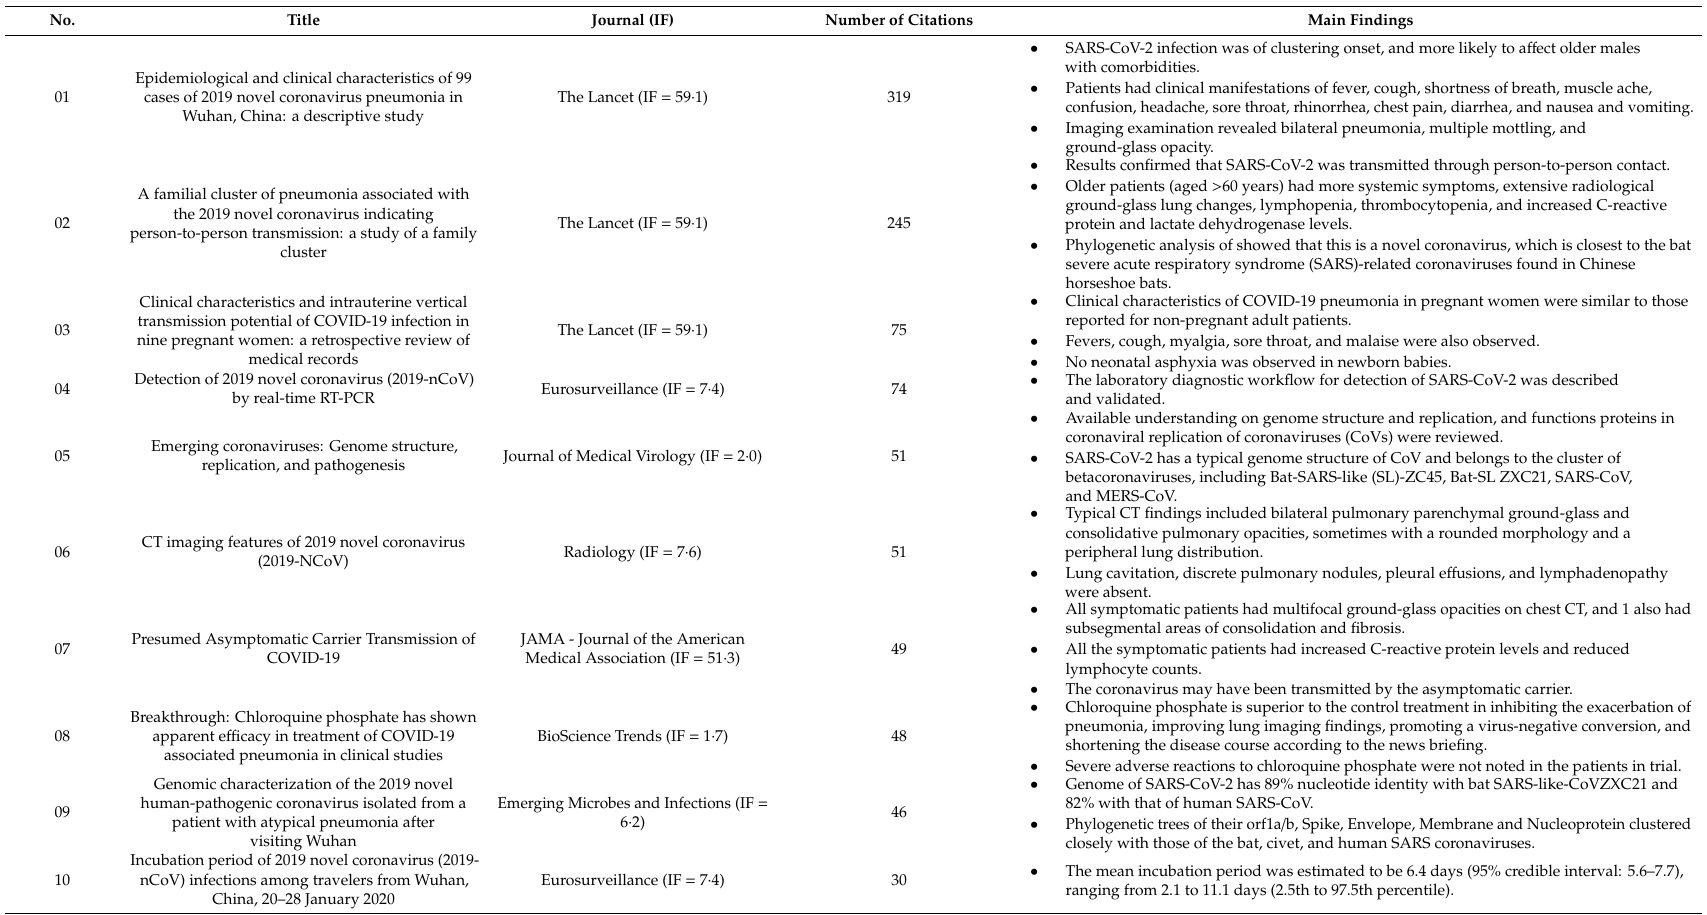
Table 1. Top ten most cited